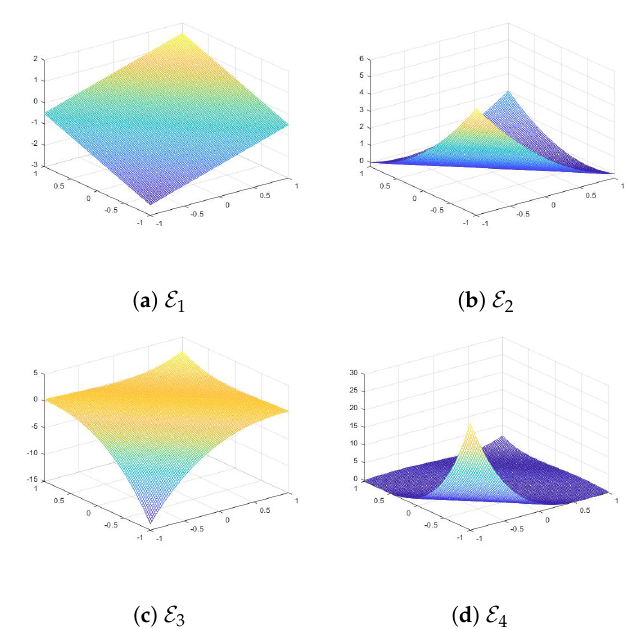
Figure 3. Plot of E i , i = 1, . . . ,4, in [ − 1,1 ] × [ − 1,1 ]